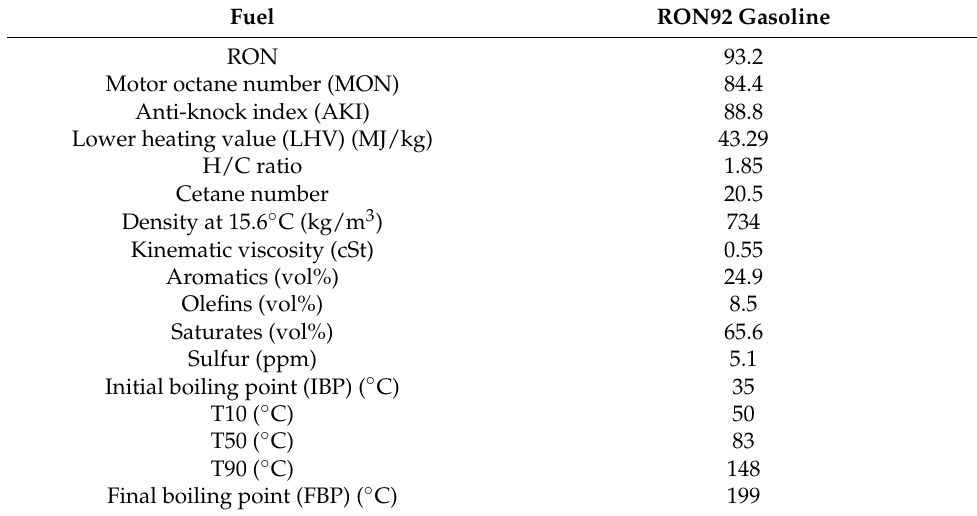
Table 2. RON92 gasoline